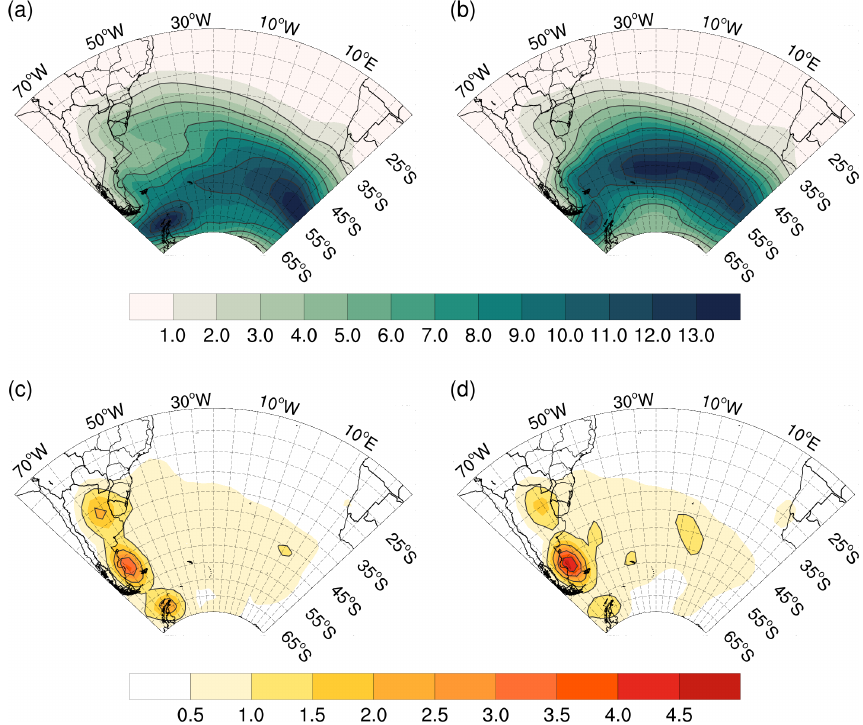
Figure B1. Cyclone (a, b) track and (c, d) genesis density in phase (a, c) A and (b, d) B of EOF1 of u 10 . Dashed contours show 2 density unit intervals for the track and 1 for the genesis. Density unit is the system per year per area, where area is in 10 6 km 2 ( ∼ 5 ◦ spherical cap).